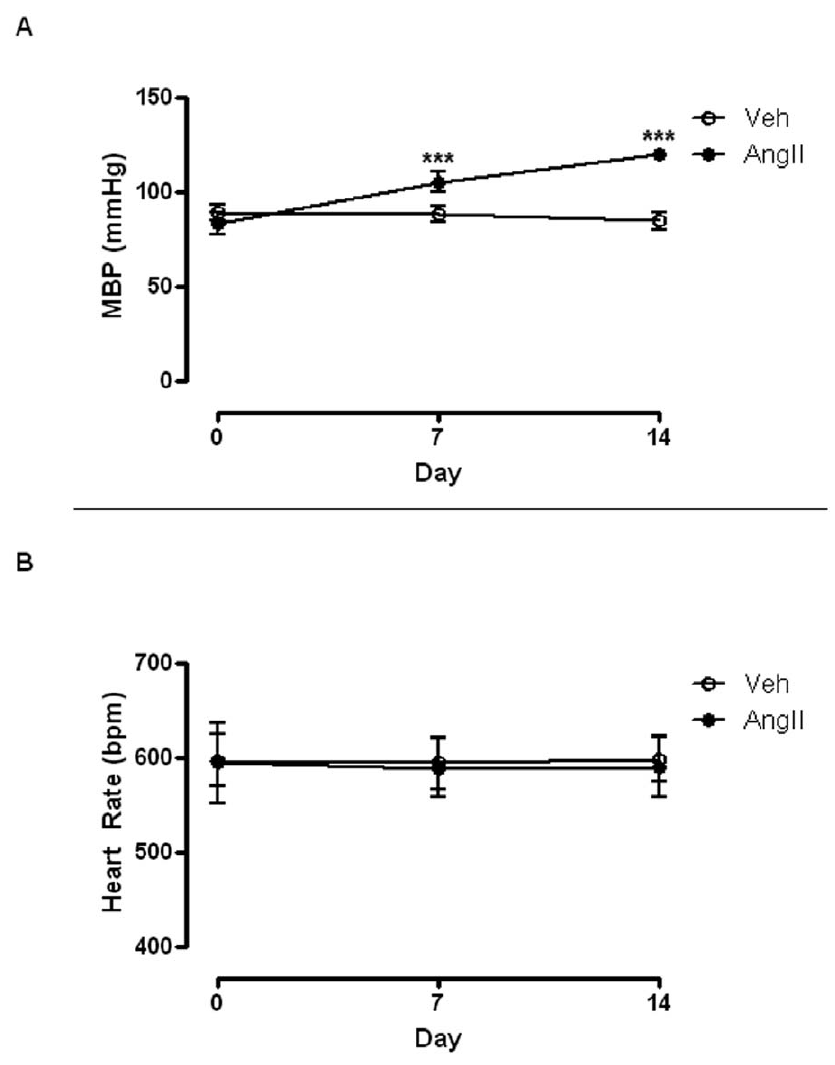
Figure 1. AngII infusion increases mean blood pressure in ApoE 2 / 2 mice. Effects of AngII infusion on (A) heart rate and (B) mean blood pressure (MBP) in ApoE 2 / 2 mice. Results are mean 6 SEM (n=6); Statistical significance shown as ***P , 0.0001.